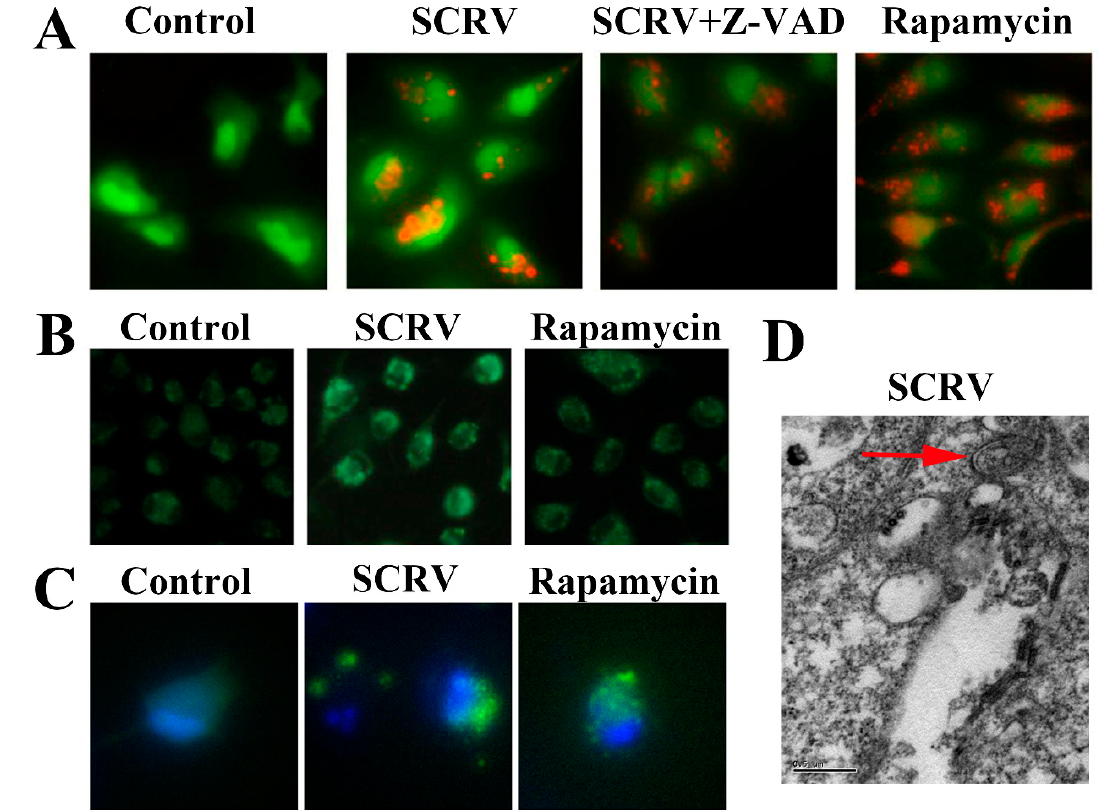
Figure 1. Autophagy induction analysis in SCRV-infected EPC cells. ( A , B ) Stand up the acidic vesicles and autophagosome structures of infected cells by AO and MDC staining, respectively. Apoptosis inhibitor Z-VAD-FMK (abbreviated Z-VAD) and autophagy inducer rapamycin were also explored to incubate SCRV-infected cells, respectively. (Original magnification, ×200). ( C ) Punctuate aggregations of LC3 were detected in EPC cells after transfection with recombinant pEGFP-LC3 vector. Hoechst 33342 was used to stain the nuclei. ( D ) Electron microscope observation of autophagic double-membrane structure (denoted by the red arrow) in SCRV-infected cells. (Original magnification, ×80k).